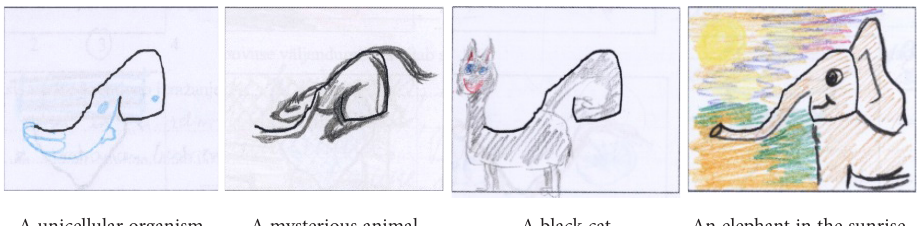
Figure 10. The creative task: interpretation of Fragment 2 – the variety of animals (source: testingmom.com,